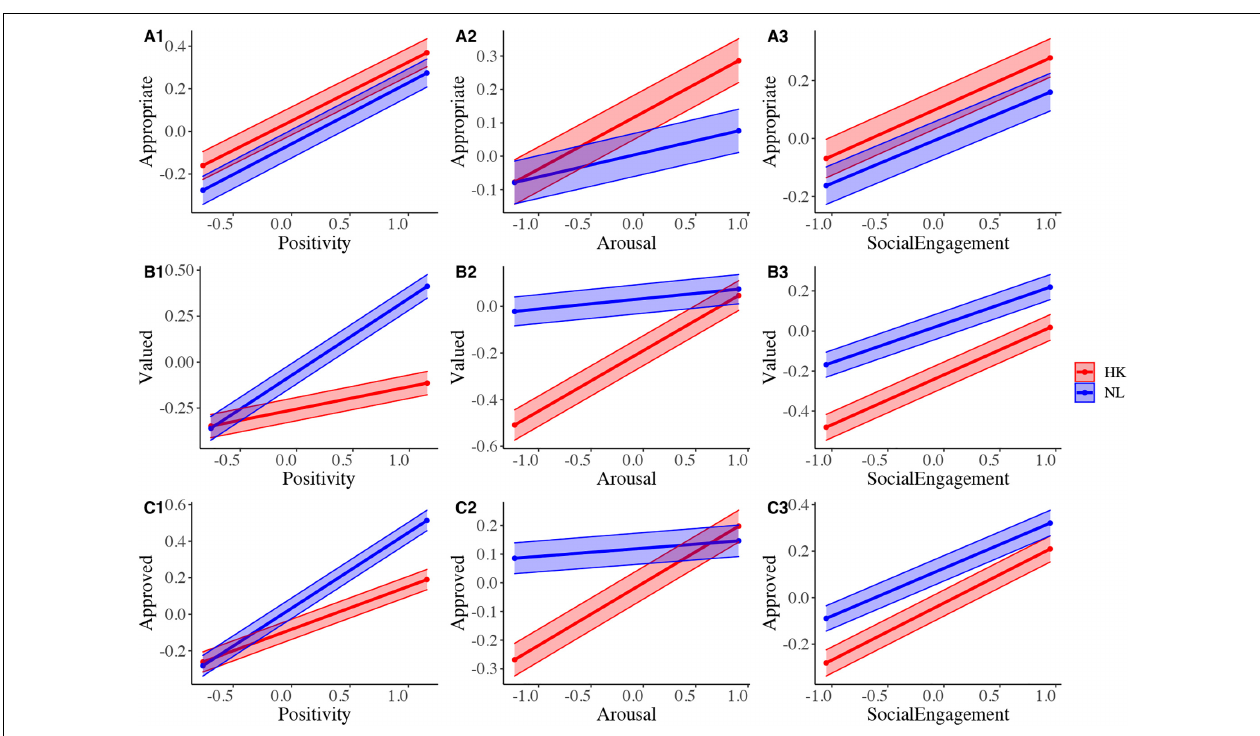
FIGURE 1 | Moderating effect of culture on the associations between individual perceptions and societal evaluations, with 95% confidence intervals displayed. (A1–A3) display results for “Appropriate”, (B1–B3) display results for “Valued”, and (C1–C3) display results for “Approved of”.